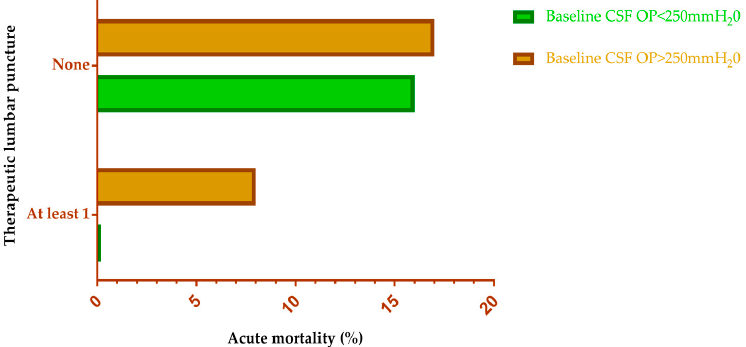
Figure 2. Therapeutic lumbar puncture and acute mortality in HIV-infected individuals with cryptococcal meningitis. Repeated therapeutic lumbar puncture is associated with improved survival regardless of initial CSF opening pressure. Data obtained from Rolfes et al. [67]. CSF: